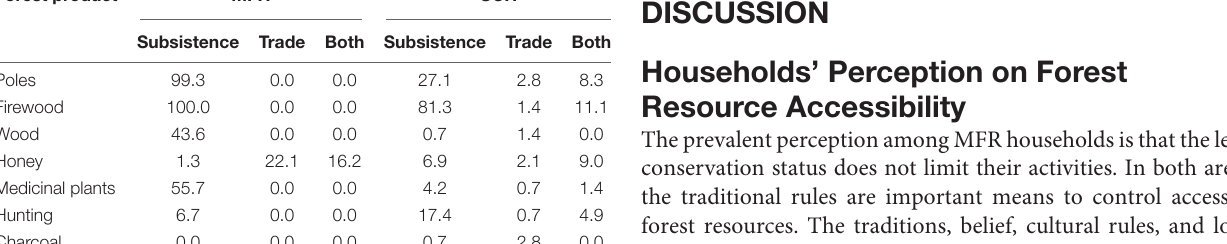
TABLE 7 | Gathering forest products for subsistence and/or for trade in MFR and SCH (percentage of households). Forest product MFR